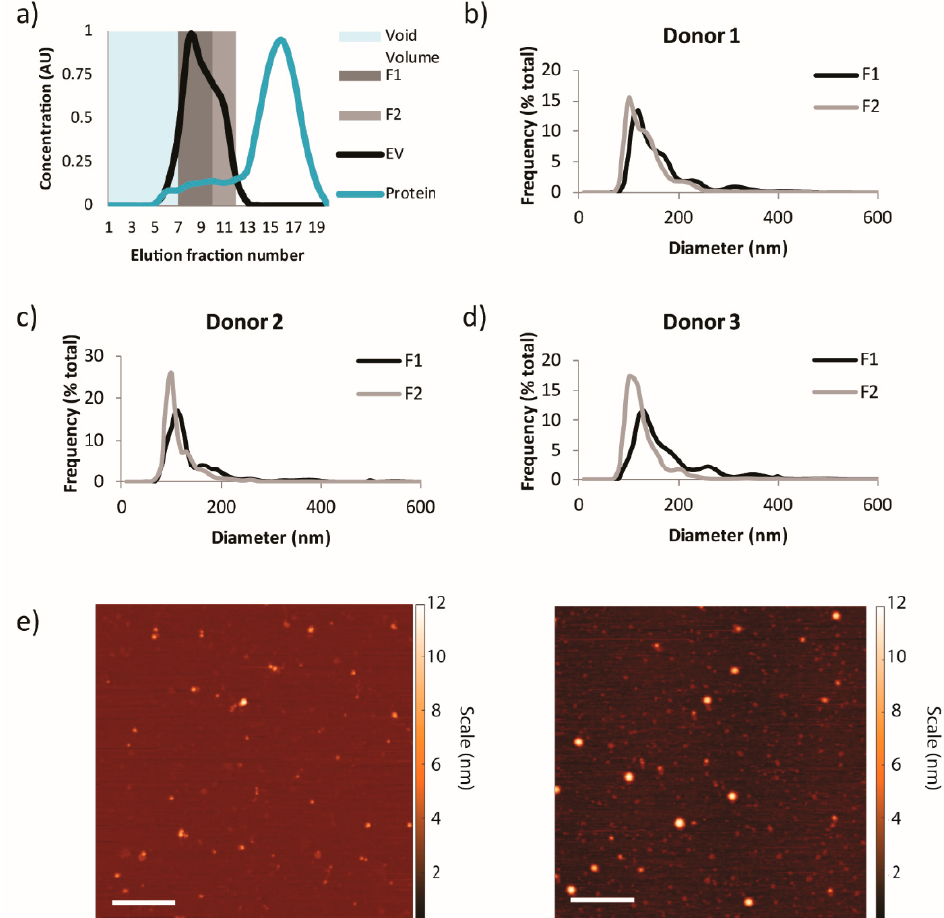
Figure 2. Size and morphology of plasma-derived extracellular vesicles (EVs) collected through size exclusion chromatography (SEC). ( a ) Schematic of expected content in SEC pooled elution fractions (F). F1 and F2 correspond to elution fractions 7–9 and 10–11, respectively. ( b – d ) Size distribution plots obtained from nanoparticle tracking analysis (NTA). ( e ) Representative atomic force microscopy images of fraction 1 ( left ) and fraction 2 ( right ) from donor 1. Scale bar, 500 nm.